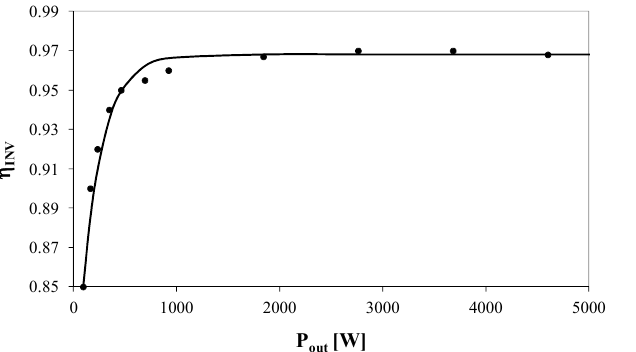
Figure 6. Measured and computed dependencies of the energy efficiency of the inverter on its output power.